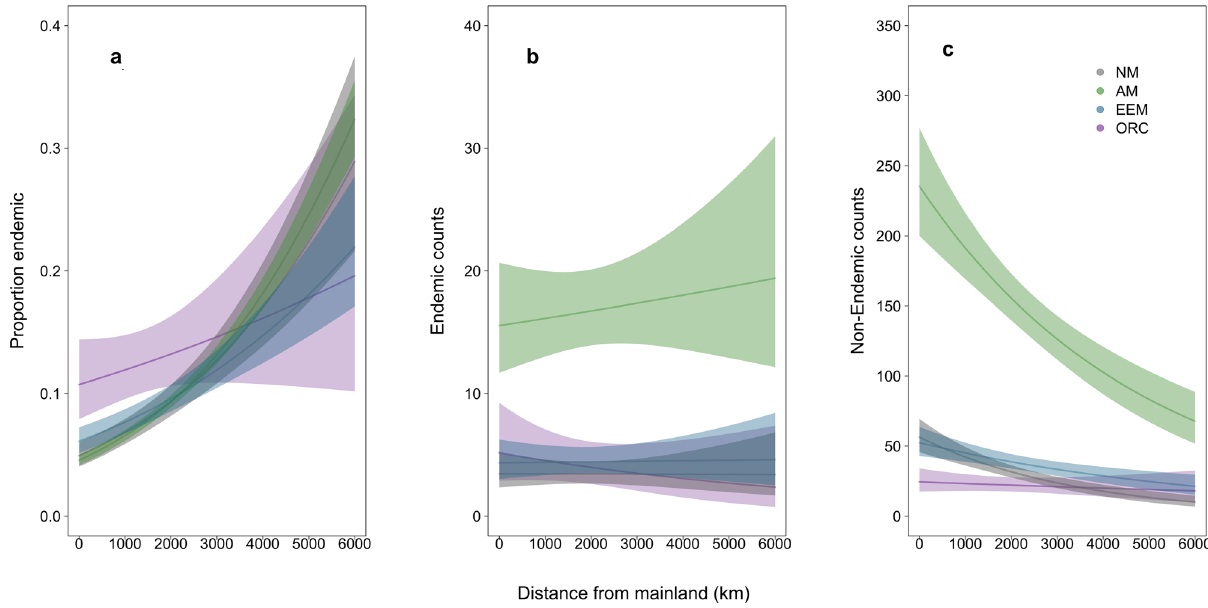
Fig. 4 Variation in mycorrhizal types in oceanic island fl oras with distance from mainland source regions. The proportion of plant species endemic to non-endemic increases most rapidly with distance for AM plant species ( a estimate = 0.432 ± 0.063, p < 0.001, n = 254; GLM). The number of endemic AM species does not change with distance ( b estimate 0.048 ± 0.147, p = 0.74, n = 254; GLM). The non-endemic species for AM decreases most strongly compared to other mycorrhizal types and to NM plants ( c estimate = − 0.265 ± 0.067, p < 0.001, n = 254; GLM). Con fi dence intervals represent 95% con fi dence